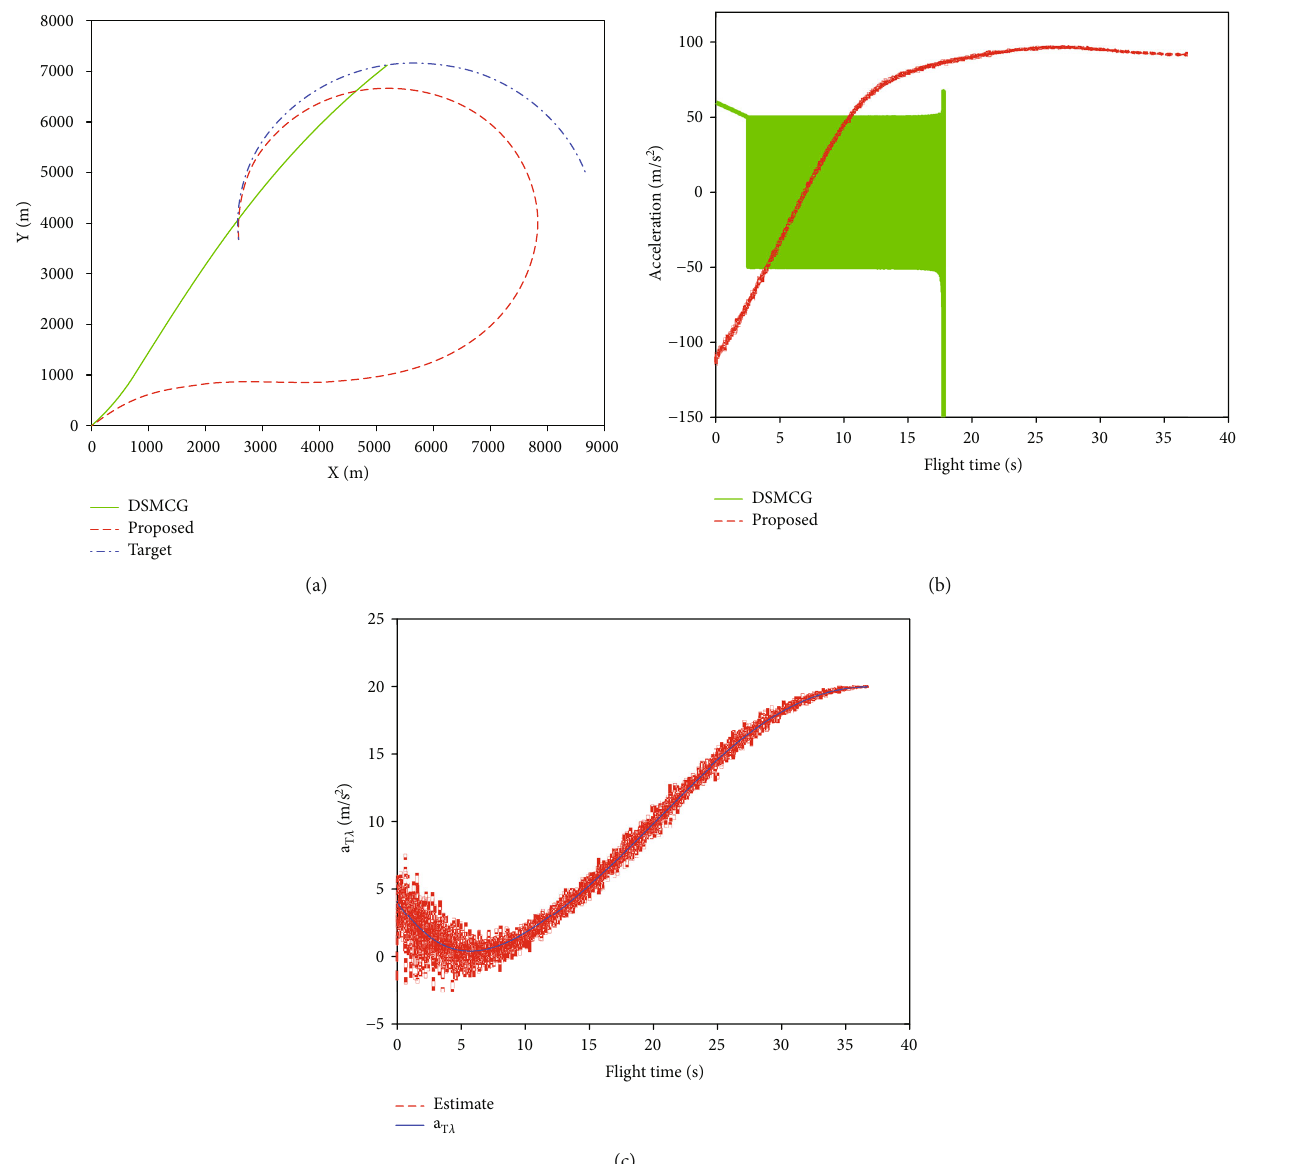
Figure 5: Simulation results under the proposed guidance law for Case 1: (a) interception trajectory; (b) achieved acceleration; and (c) target maneuver